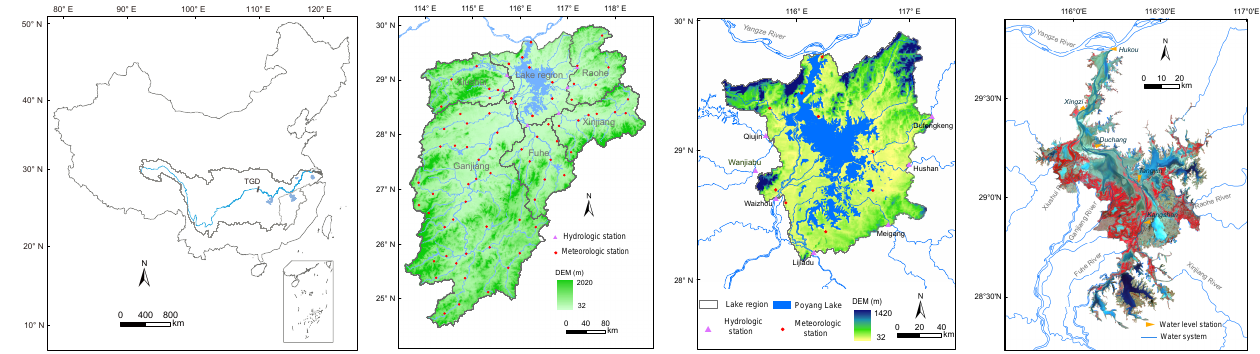
Figure 1. Geographic location of Poyang Lake, China. The lake is principally fed by five river systems of the Poyang Lake basin. Lake water flows into the Yangtze River via a single outlet at the Hukou. Jiujiang is located 25km upstream of the Hukou on the Yangtze River. The Three Gorges Dam (TGD) is upstream of the